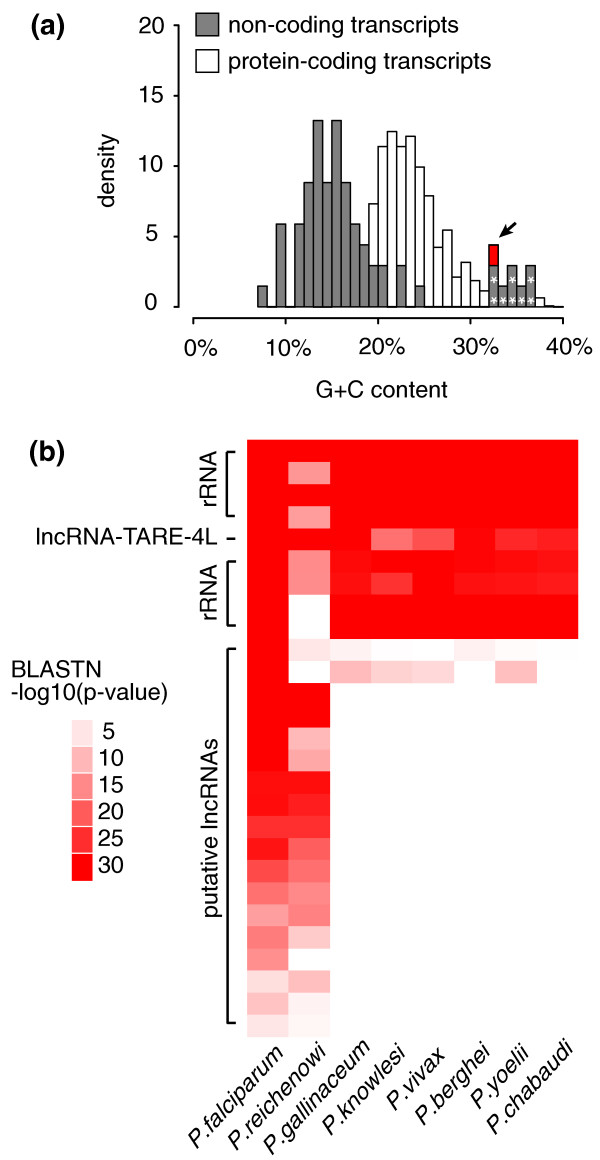
Additional characterization of putative lncRNAs highlights the striking properties of a telomere-associated lncRNA. (a) Guanine-cytosine (G+C) content comparison between predicted non-coding and protein-coding transcripts shows that non-coding G+C content is typically lower than coding transcript G+C content. lncRNA-TARE-4L (highlighted in red and indicated by arrow) and ribosomal RNAs (indicated by asterisks) have high G+C content. (b) The sequence of eight functional rRNAs is broadly conserved across Plasmodium species. The sequence of 19 putative lncRNAs is also significantly conserved in at least one other species (BLASTN P-value < 0.01), suggesting a preserved functional role. lncRNA-TARE-4L is strongly conserved across all eight species analyzed. Such a broad level of conservation is rarely seen in randomly sampled intergenic regions from P. falciparum (P-value = 0.045). Rows are ordered by number of species with BLASTN hits (P-value < 0.01), and then by strength of hits (defined by the product of P-values). Species are clustered based on the phylogeny proposed by Escalante and Alaya [86]. BLAST, basic local alignment and search tool.